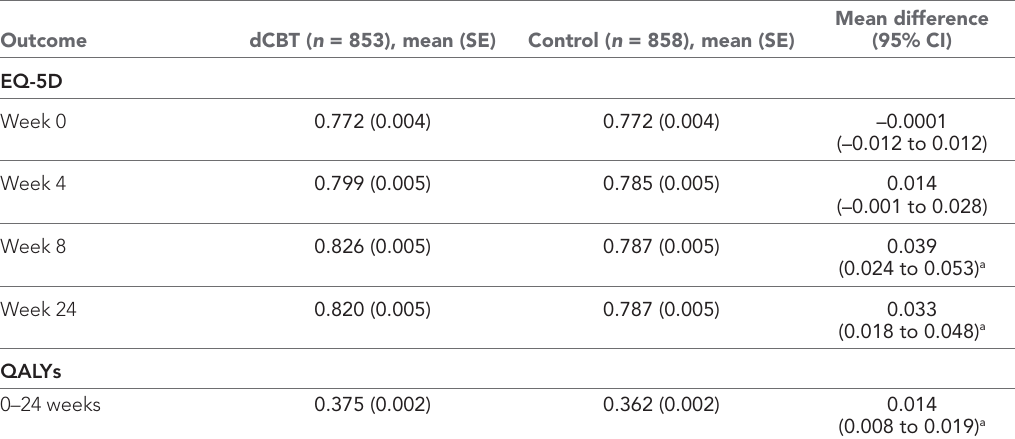
Table 1 EQ- 5D scores and QALYs to 24 weeks, with multiple imputation used to handle missing values